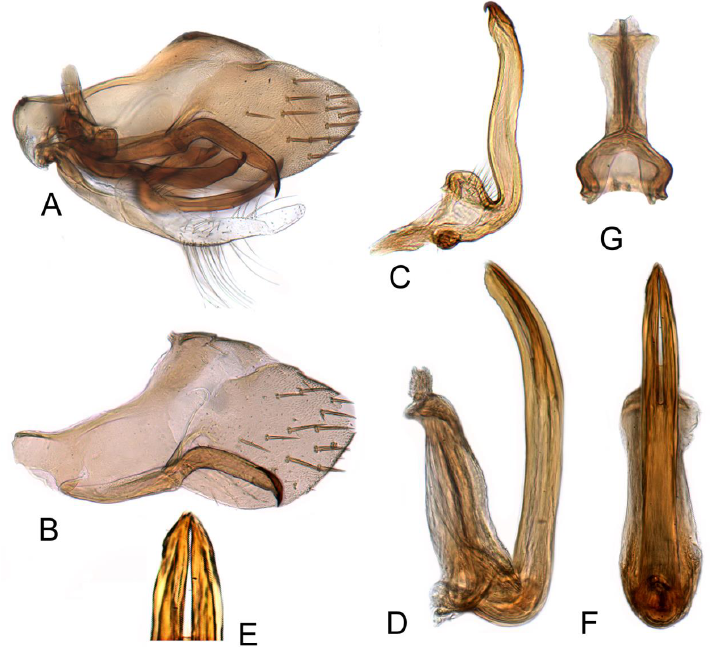
Insects 2021 , 12 , x 13 of 23 Figure 6. Batracomophus pandarus Knight, 1983: ( A ) genital capsule in lateral view; ( B ) pygofer side and pygophore pro- Figure 6. Batracomophus pandarus Knight, 1983: ( A ) genital capsule in lateral view; ( B ) pygofer side and pygophore processes; cesses; ( C ) styles; ( D ) aedeagus, lateral view; ( E ) aedeagus apex, ventral view; ( F ) aedeagus, ventral view; ( G ) connective. setae along both margins. Aedeagus simple, shaft elongate, slender in lateral aspect, curv- ( C ) styles; ( D ) aedeagus, lateral view; ( E ) aedeagus apex, ventral view; ( F ) aedeagus, ventral view; ( G ) connective. ing anterodorsally, laterally expanded in distal 1/3 subapically in posterior aspect, apical 3.3.3. Batracomorphus subfuscus (Li and Wang, 1993) incision very short. Figures 2G – I and 7A – G Iassus subfuscus Li and Wang, 1993: 18, Figure 4A – E [18]. Batracomorphus nigromarginattus Cai and Shen, 1999: 37 [47]; Cai, He and Gu, 2001: 187 [42]; Fang and Wu, 2001:34 [48]; Zhang et al., 2017:190 [46]. syn. nov. Batracomorphus subfuscus , Li and Wang, 2003: 131 [19]. Description. Male 5.8 – 7.9 mm long, 1.2 – 1.3 mm wide across eyes, 2.1 – 2.2 mm wide across hind margin of pronotum. Colour pale yellowish. Forewing with appendix piceous. Pygofer side longer than height, tapering to acute apex, with many macrosetae near posterior margin, inner process moderately slender, extended straight posterodorsad to mid-length then bent posteroventrad, ventral margin serrate near apex, apex acuminate. Style thin, abruptly narrowed and sinuate in distal 1/4, apex hooked ventromesad. Con- nective stem gradually expanded posteriorly. Sub-genital plate thin, with many long fine